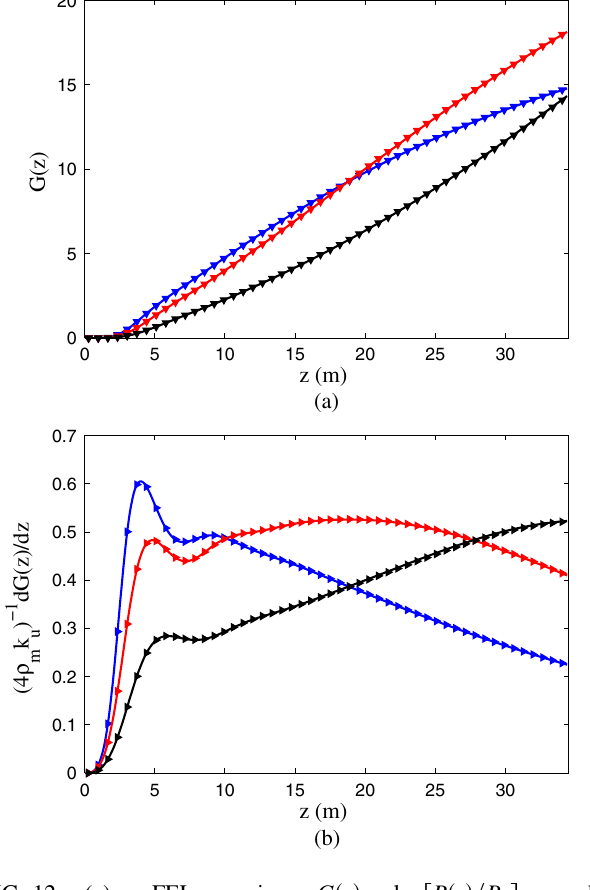
FIG. 12. (a) FEL gain G ð z Þ ¼ log ½ P ð z Þ =P (b) normalized local power growth rate ð 4 (cid:13) for three unfocused beams with (cid:7) 0 = 17 : 225 = 34 : 45 m (blue/red/black, Set 2 parameters). Both 1-mode (solid curves) and 5-mode results (markers) are shown.